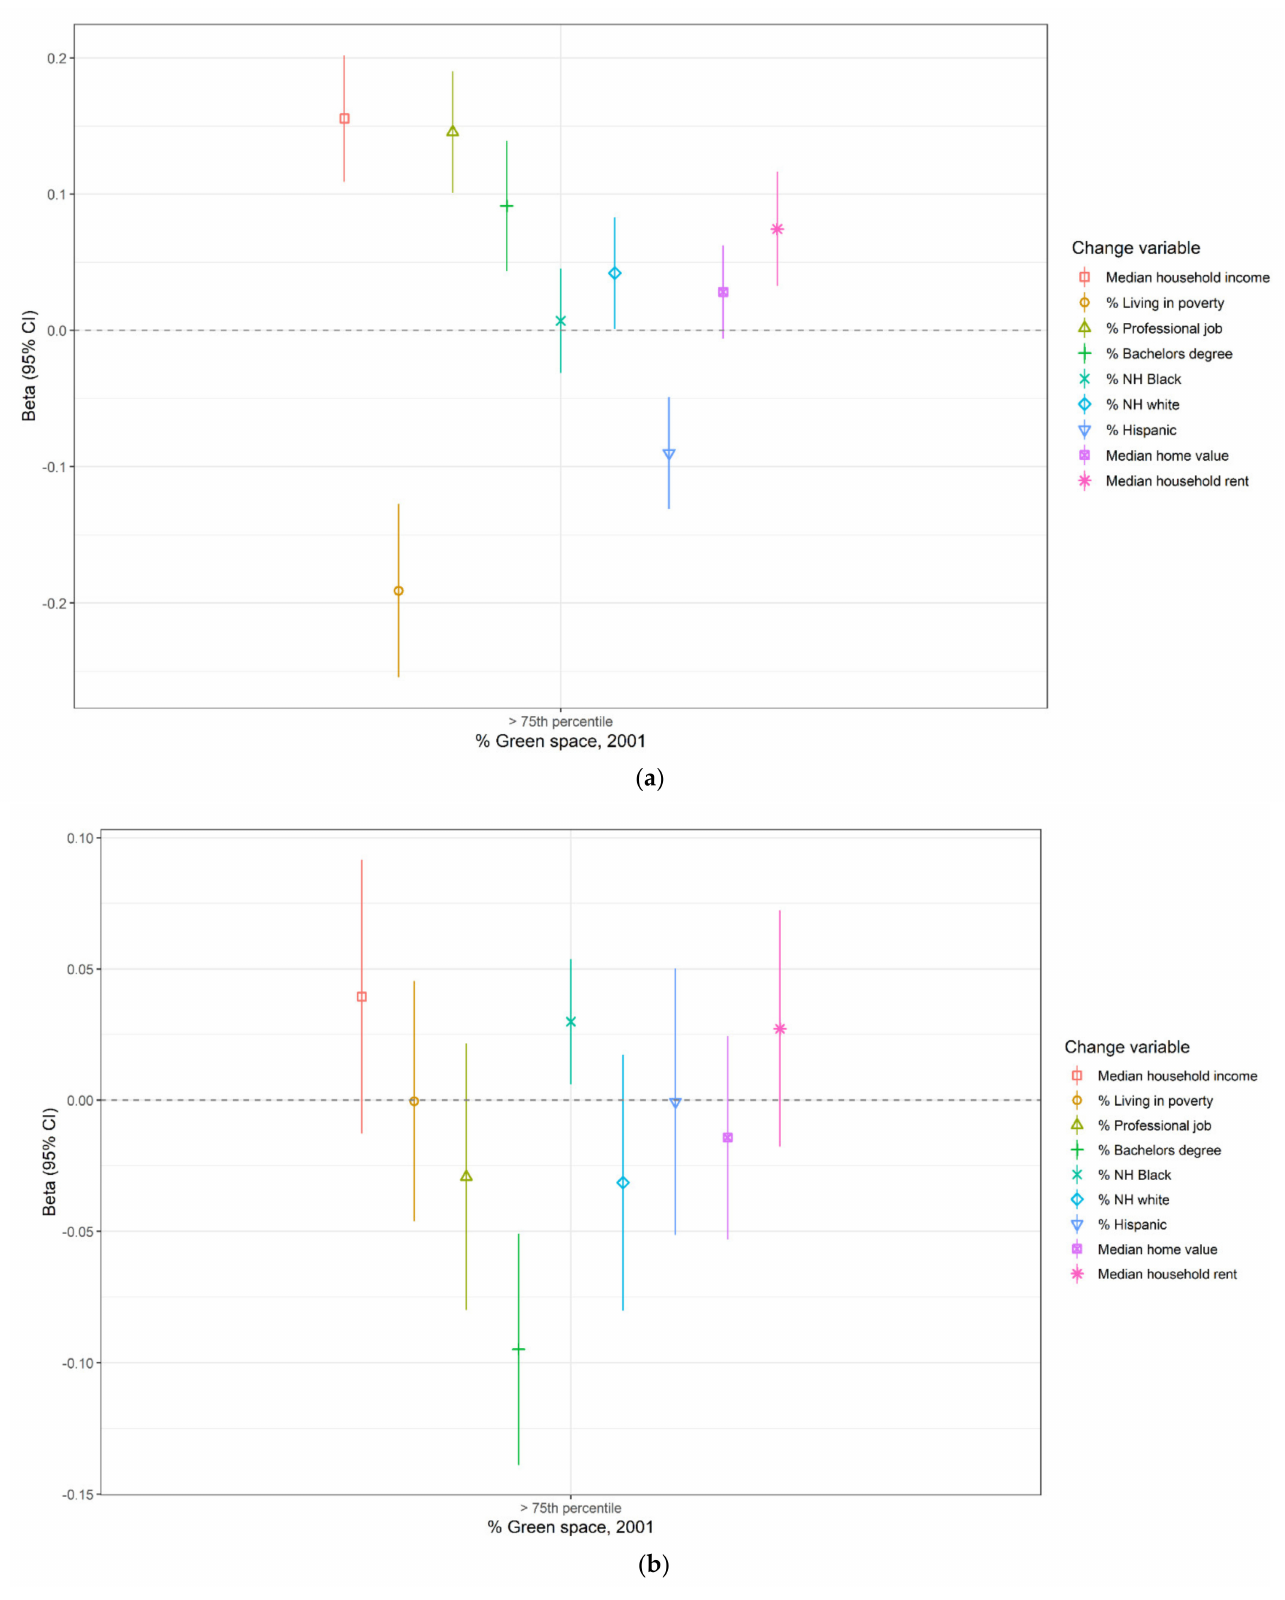
Figure 2. Meta-analytic estimates of association between percentage greenspace in 2001 and sociodemographic and housing cost changes in 2000–2010, among gentrifiable census tracts in the 43 largest MSAs in the United States: ( a ) unadjusted; ( b ) adjusted for population density in